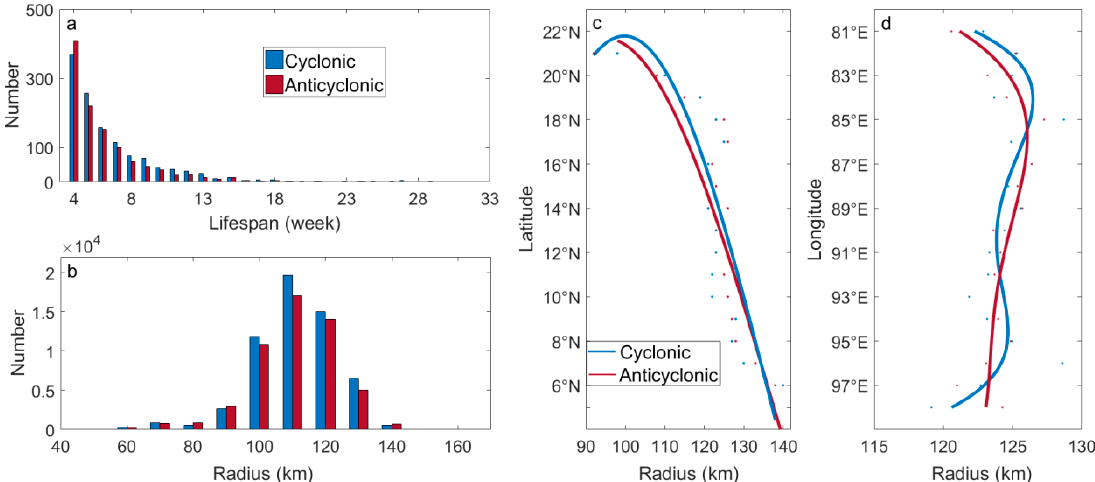
Figure 7. Eddy lifespan (lifetime ≥ 4 weeks) ( a ), radii ( b ) statistics, with change of radii by latitude ( c ) and longitude ( d ). Among them, in ( c ) and ( d ) the points represent the average radius of the eddy at each latitude (longitude), and the line represents the exponential regression result based on the corresponding point data.